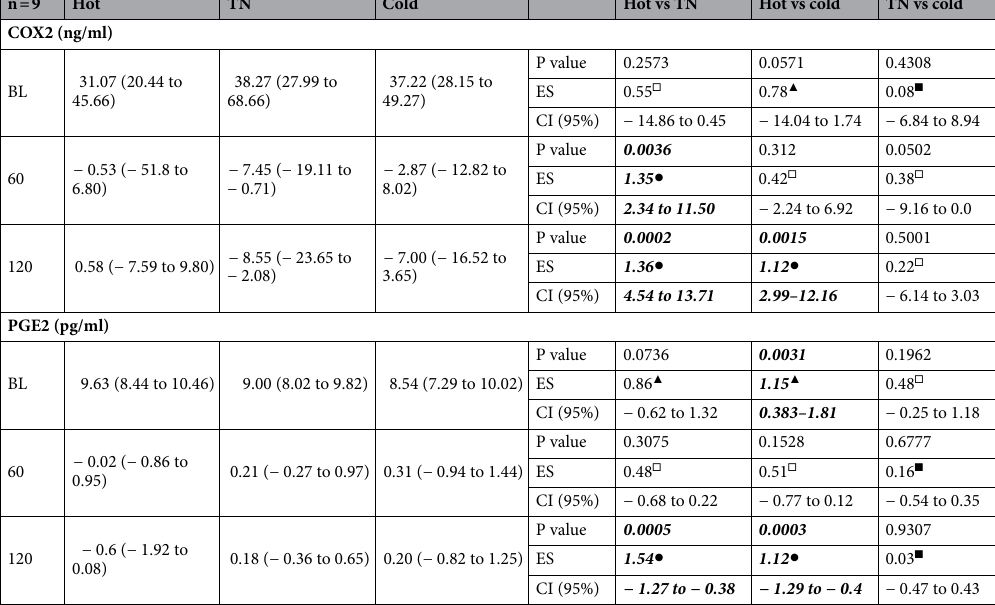
Table 2. Differences in COX2 and PGE2 concentration compared to baseline and between condition interactions. Values expressed as mean (range). Raw BL values presented for context. Bold and italic text denotes a significant finding. Symbols are used to denote the ES (e.g. ■ ‘trivial’, □ ‘small’, ▲ ‘moderate’, ● ‘large’, ○ ‘very